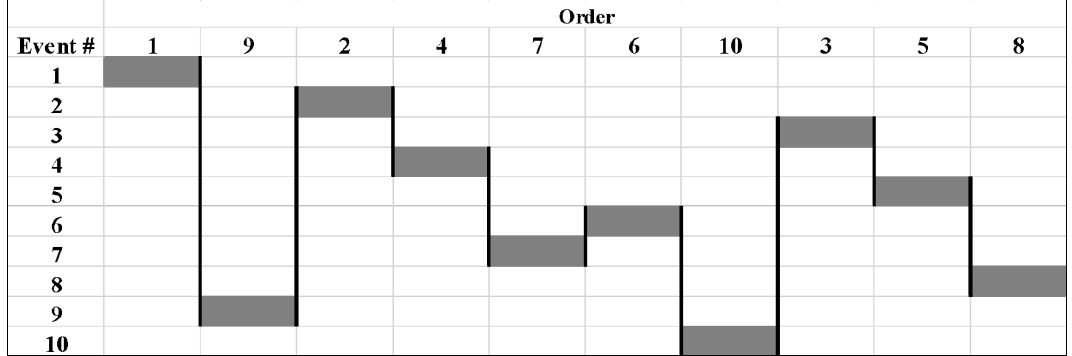
Figure 13. Selective lazy serpent proposed schedule.